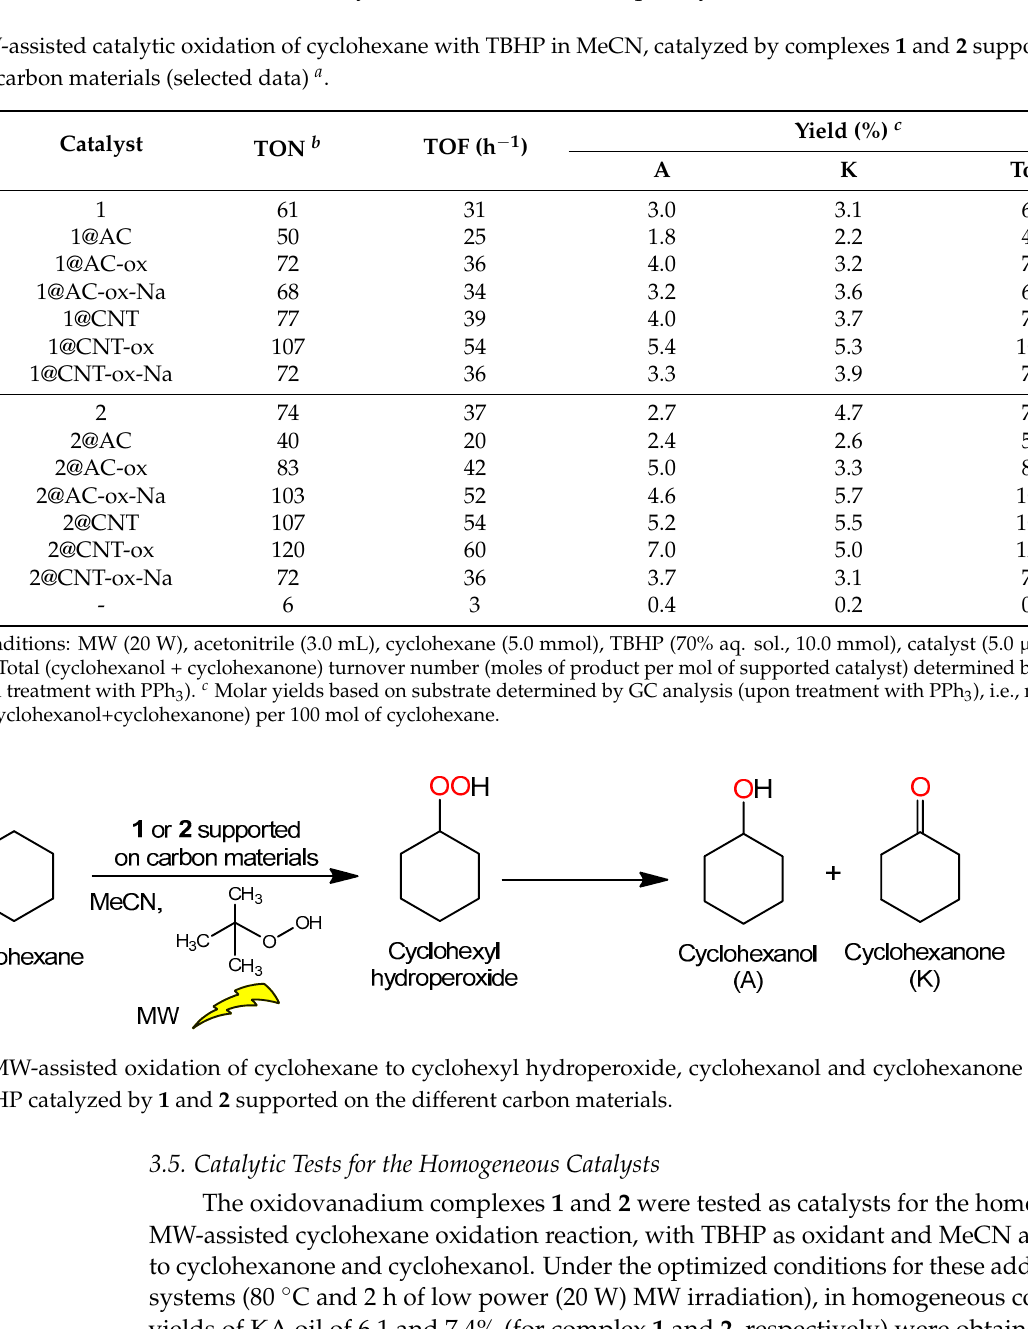
Table 4. MW-assisted catalytic oxidation of cyclohexane with TBHP in MeCN, catalyzed by complexes 1 and 2 supported on different carbon materials (selected data) a